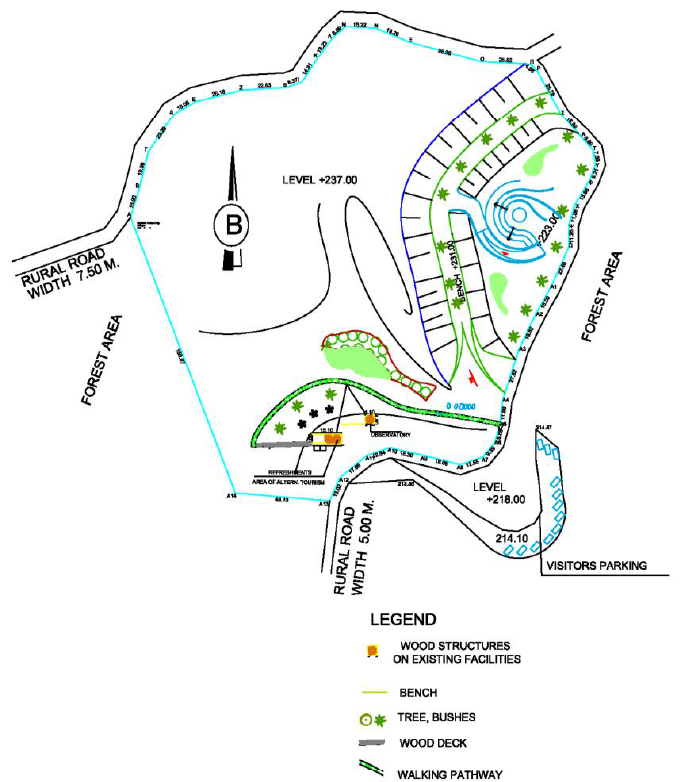
Figure 12. Restoration proposals for the quarry in Mikro Derio according to the alternative scenario A4, scale 1:2000.